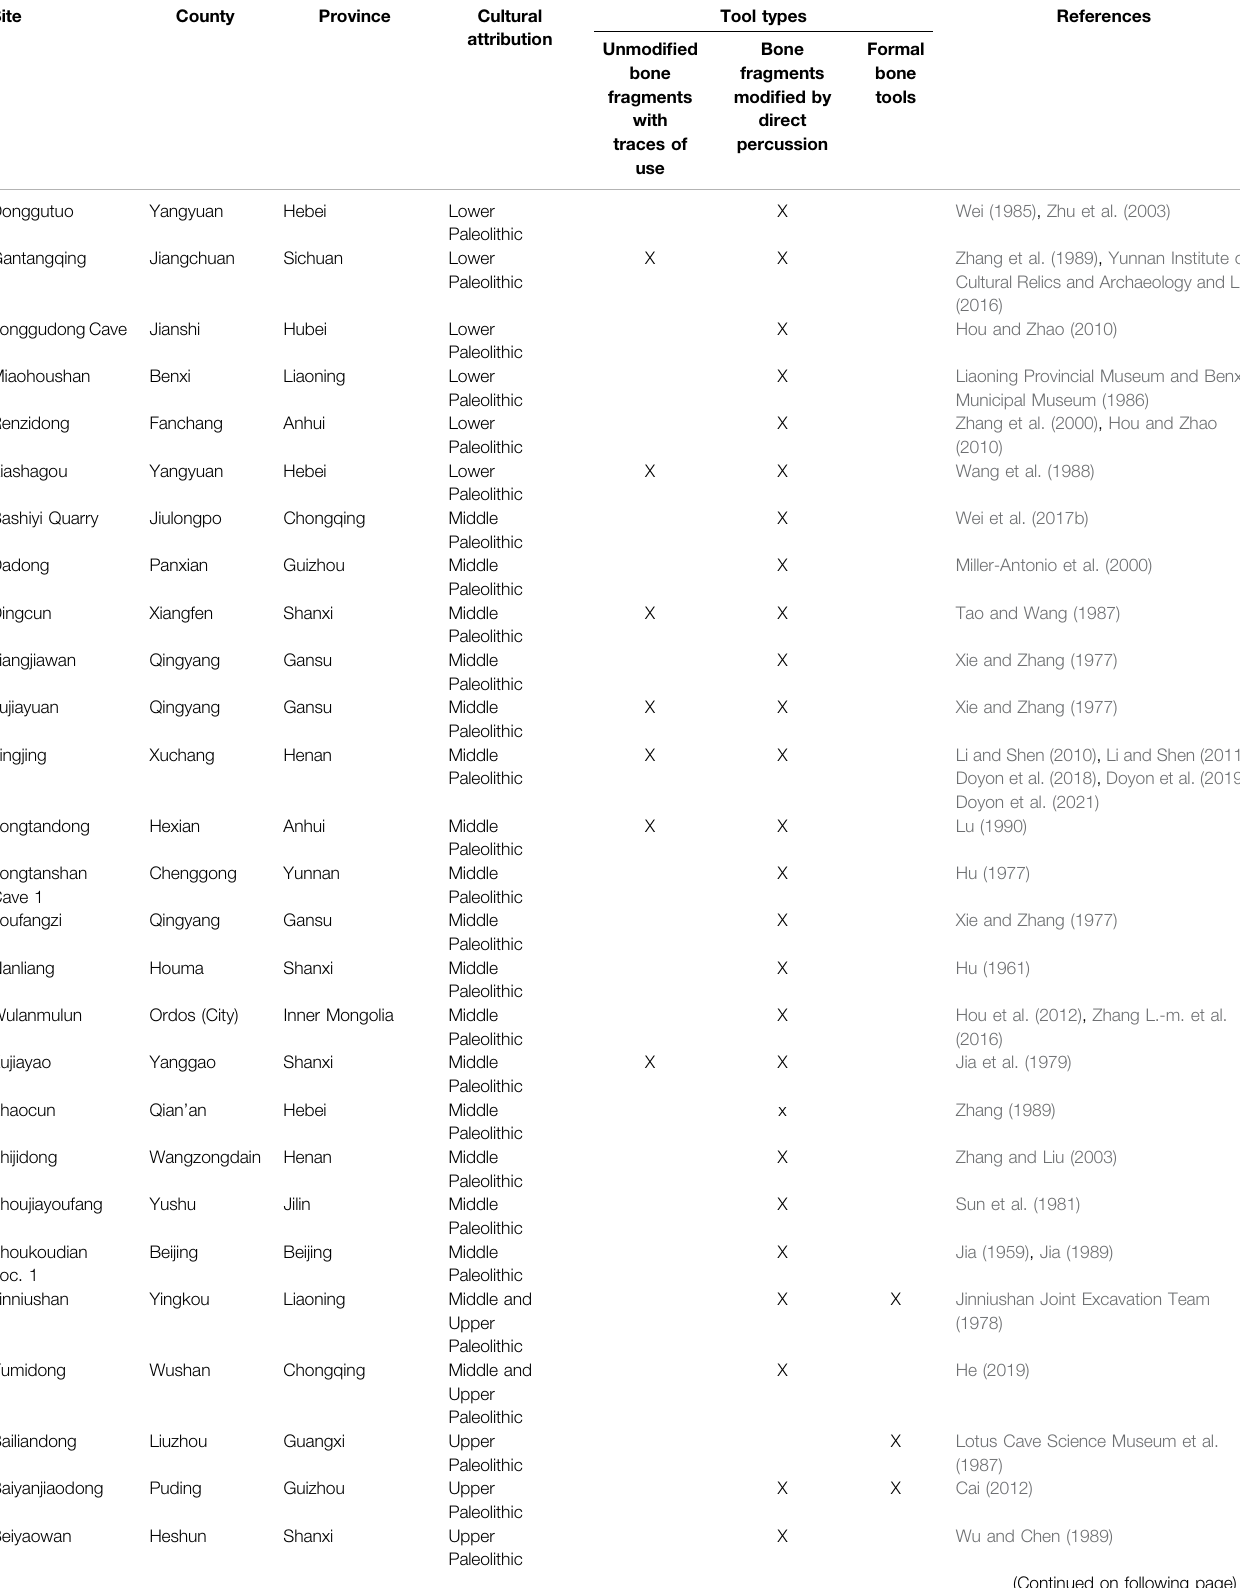
TABLE 1 | Summary of occurrence of Pleistocene osseous technology in